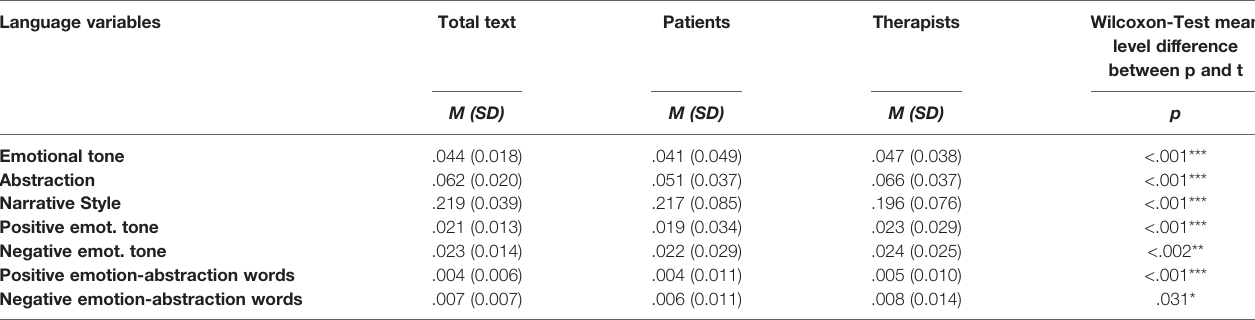
TABLE 1 | Language variables for the total text, and separately for patients and therapists. Language variables